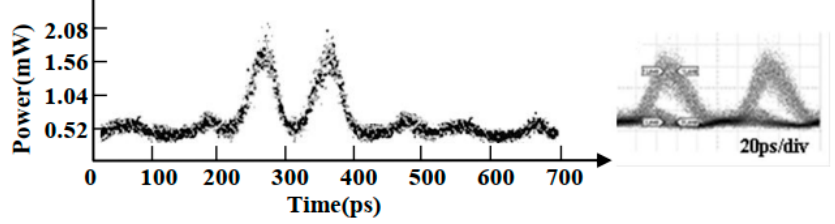
Figure 4. The output result of the all ‐ optical parity checker with errors.